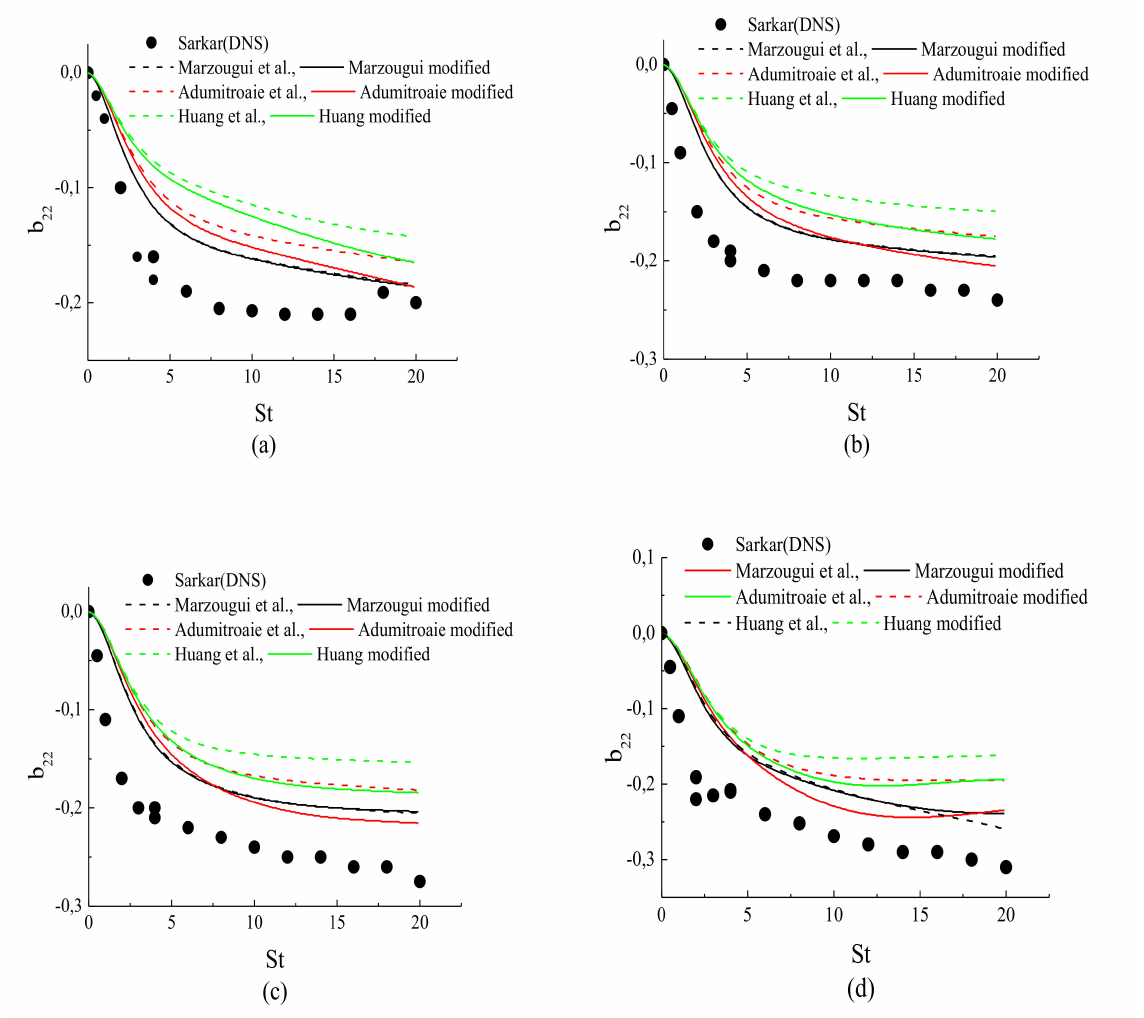
Figure 5. Time evolution of the transverse Reynolds stress anisotropy, in the following cases: ( a ) A1;